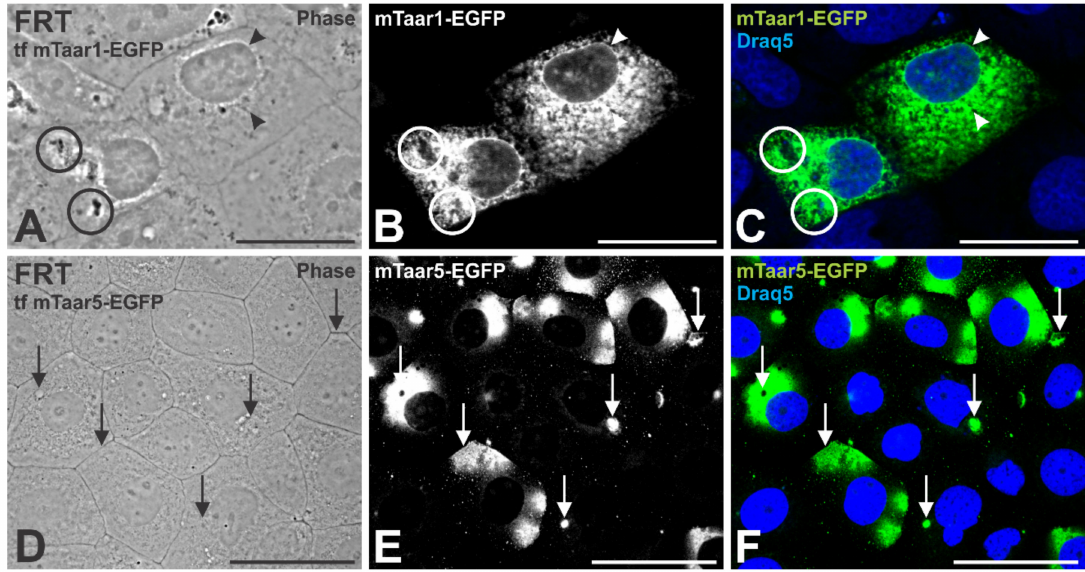
Figure 8. Transient expression of mTaar1-EGFP in Fisher rat thyroid (FRT) cells results in endoplasmic reticulum (ER) retention. ( A – C ) mTaar1-eGFP has a reticular localization in FRT cells (arrowheads), indicating mTaar1-EGFP (white in B , and green in C ) to be primarily confined to the ER when singly expressed in FRT cells. ( D – F ) FRT cells expressing mTaar5-EGFP revealed the protein (white in E , and green in F ) to frequently localize at cilia and the lateral borders between neighboring cells (arrows). Phase contrast ( A , D ) and corresponding single ( B , E ) and merged fluorescence micrographs ( C , F ) for mTaar-EGFP (green) and Draq5™ as nuclear counter-stain (blue) are shown. Circles highlight cell debris. Scale bars represents 20 µ m in ( A – C ) and 50 µ m in ( D – F